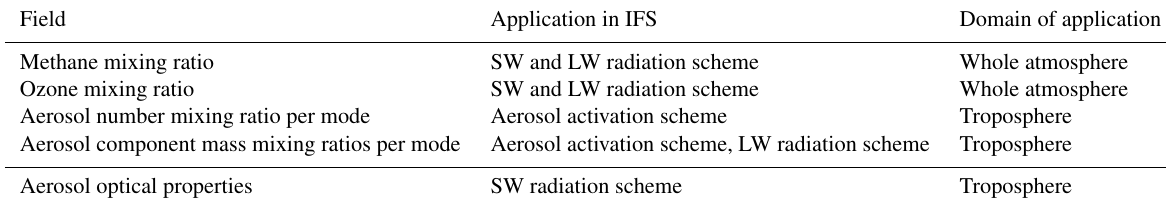
Table 6. Fields transferred from TM5 to